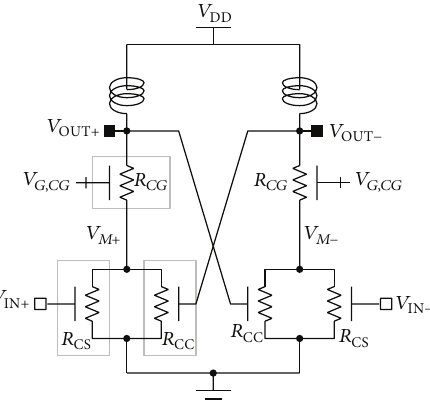
Figure 3: Ideal voltage waveforms of the cascode structure with mode-locking